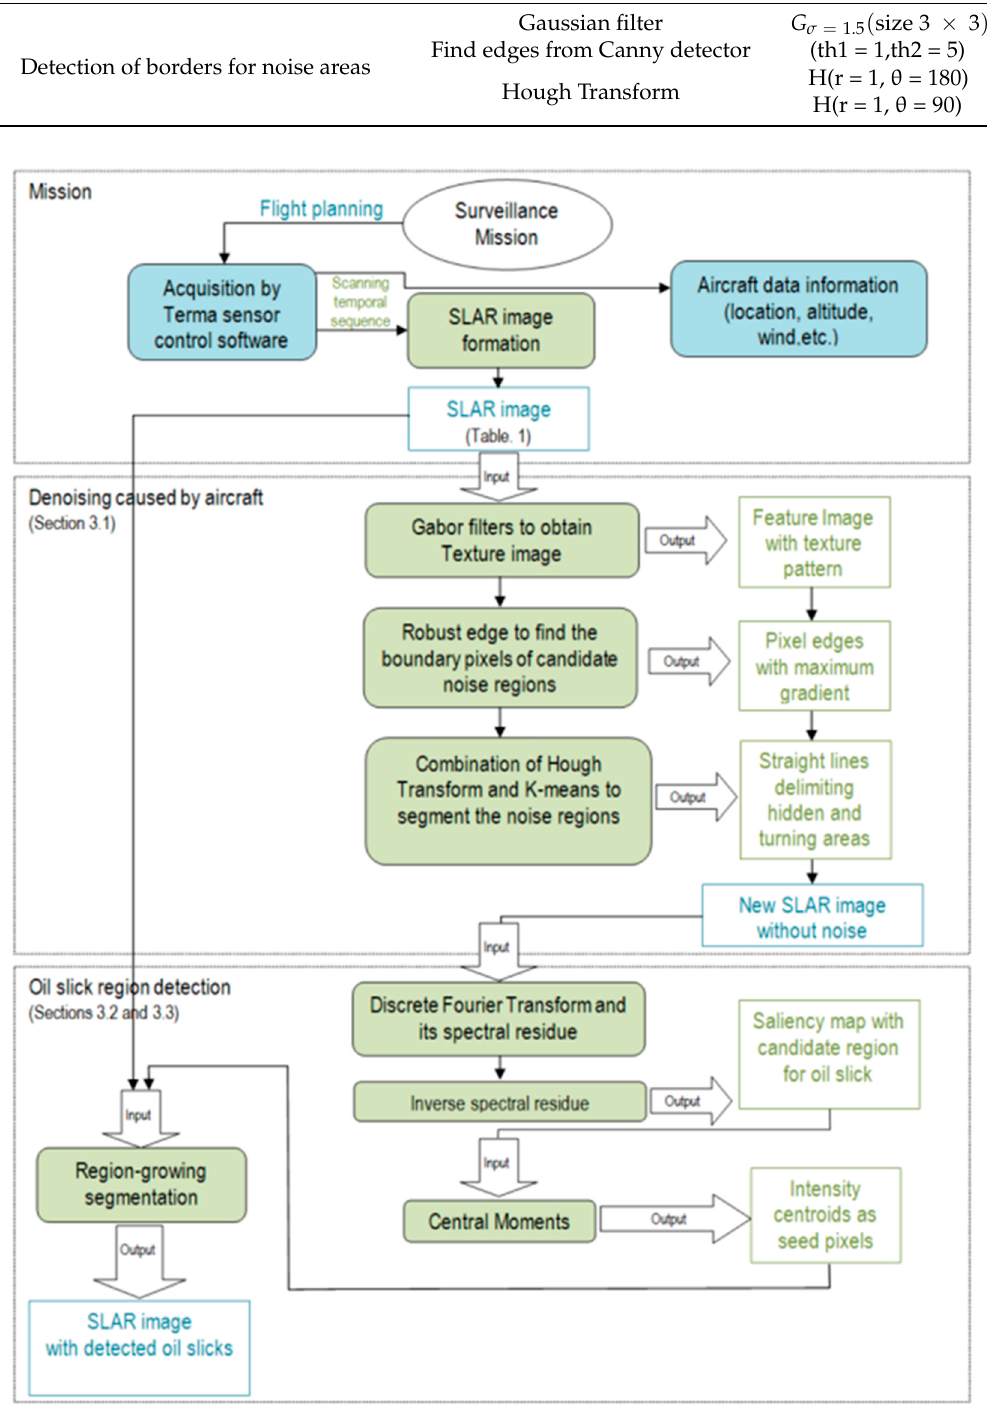
Figure 3. Scheme of method employed to detect oil slicks in SLAR image.